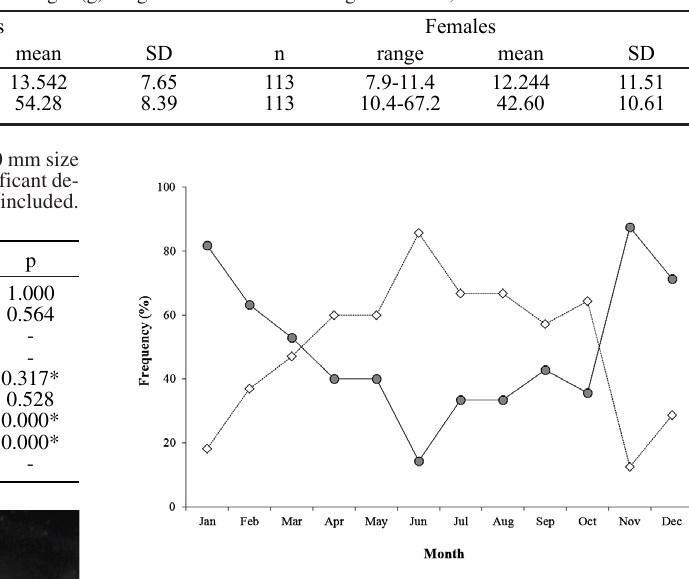
Fig. 3. – Monthly changes in otolith frequency with opaque (grey circles) and translucent (diamonts) edges.